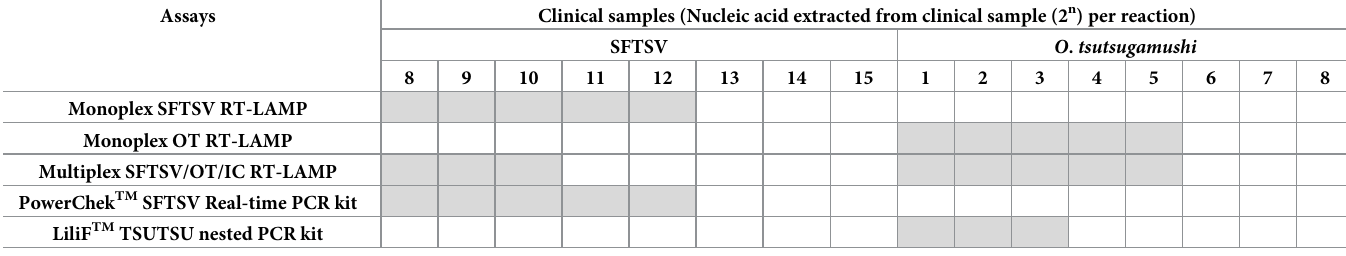
Table 3. Limit of detection tests of the multiplex SFTSV/OT/IC RT-LAMP assay, PowerChek ™ SFTSV Real-time PCR kit and LiliF ™ TSUTSU nested PCR kit for two-fold diluted clinical samples from patients infected with SFTSV or O . tsutsugamushi . Assays